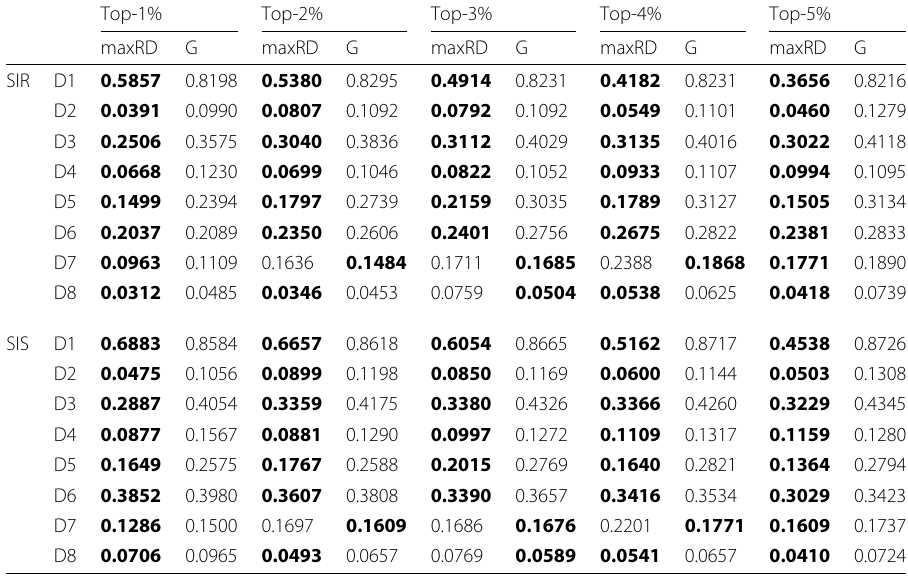
Table 2 Betweenness centrality, SIR and SIS epidemics Top-1% Top-2% Top-3%